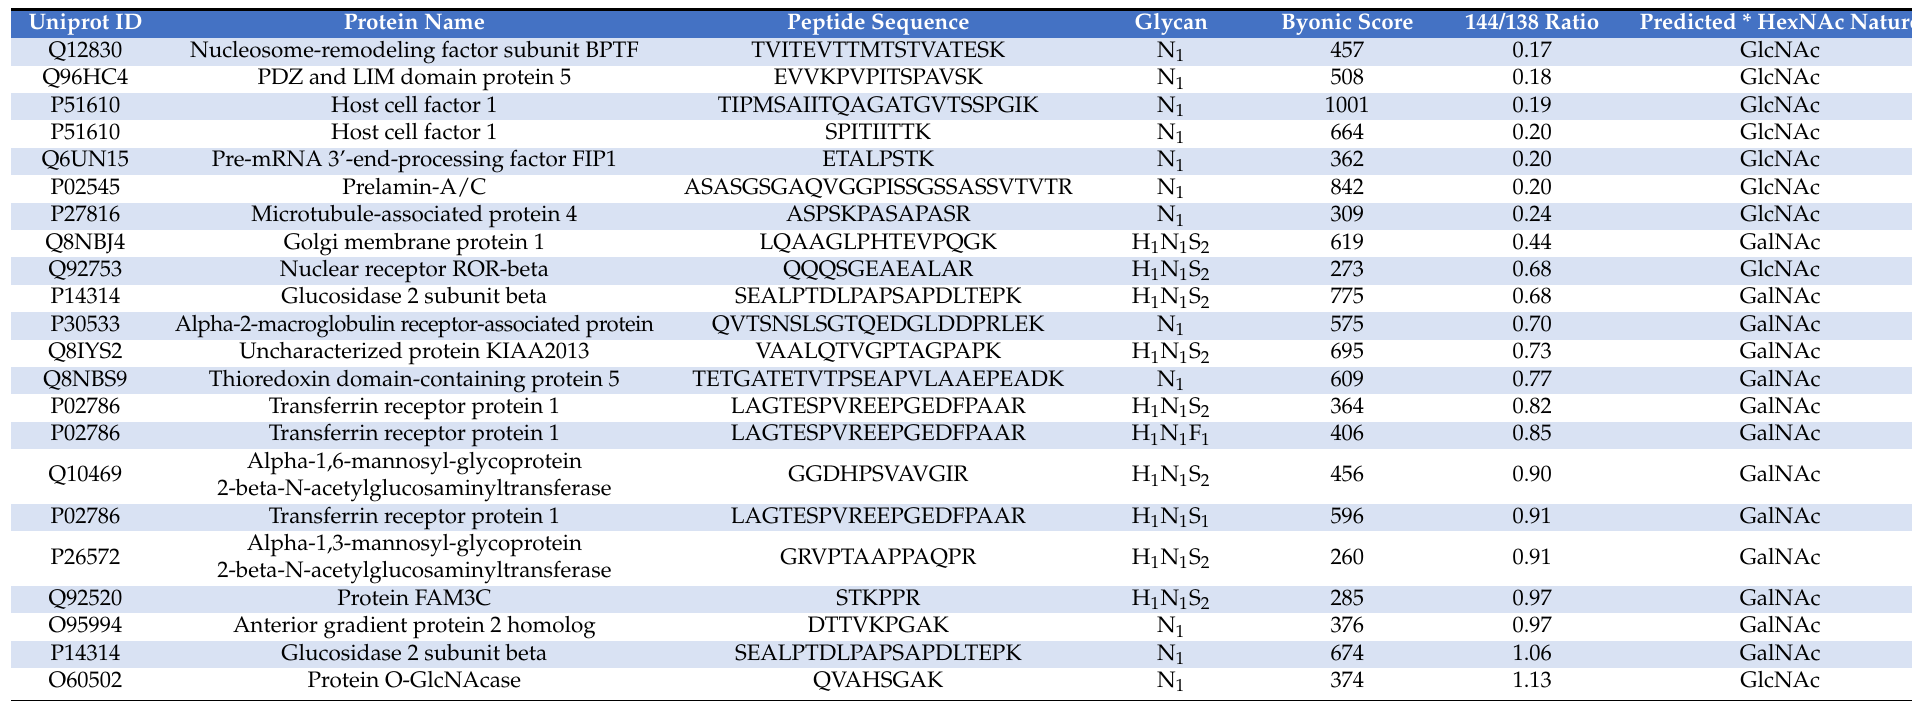
Table 1. Discrimination of O -glycopeptides with a single HexNAc based on the intensities of the oxonium ions at m / z 144.066 and 138.055 (144/138